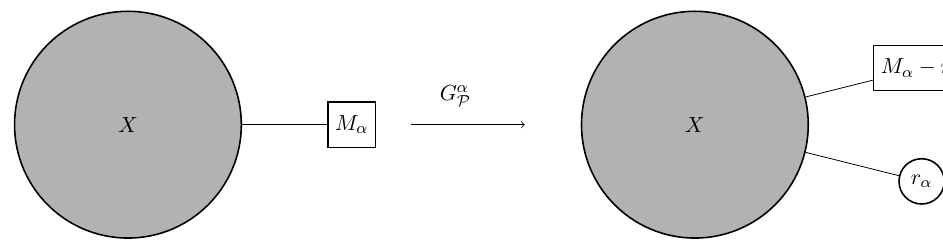
on a U( M ) subgroup of the global symmetry group of a α P